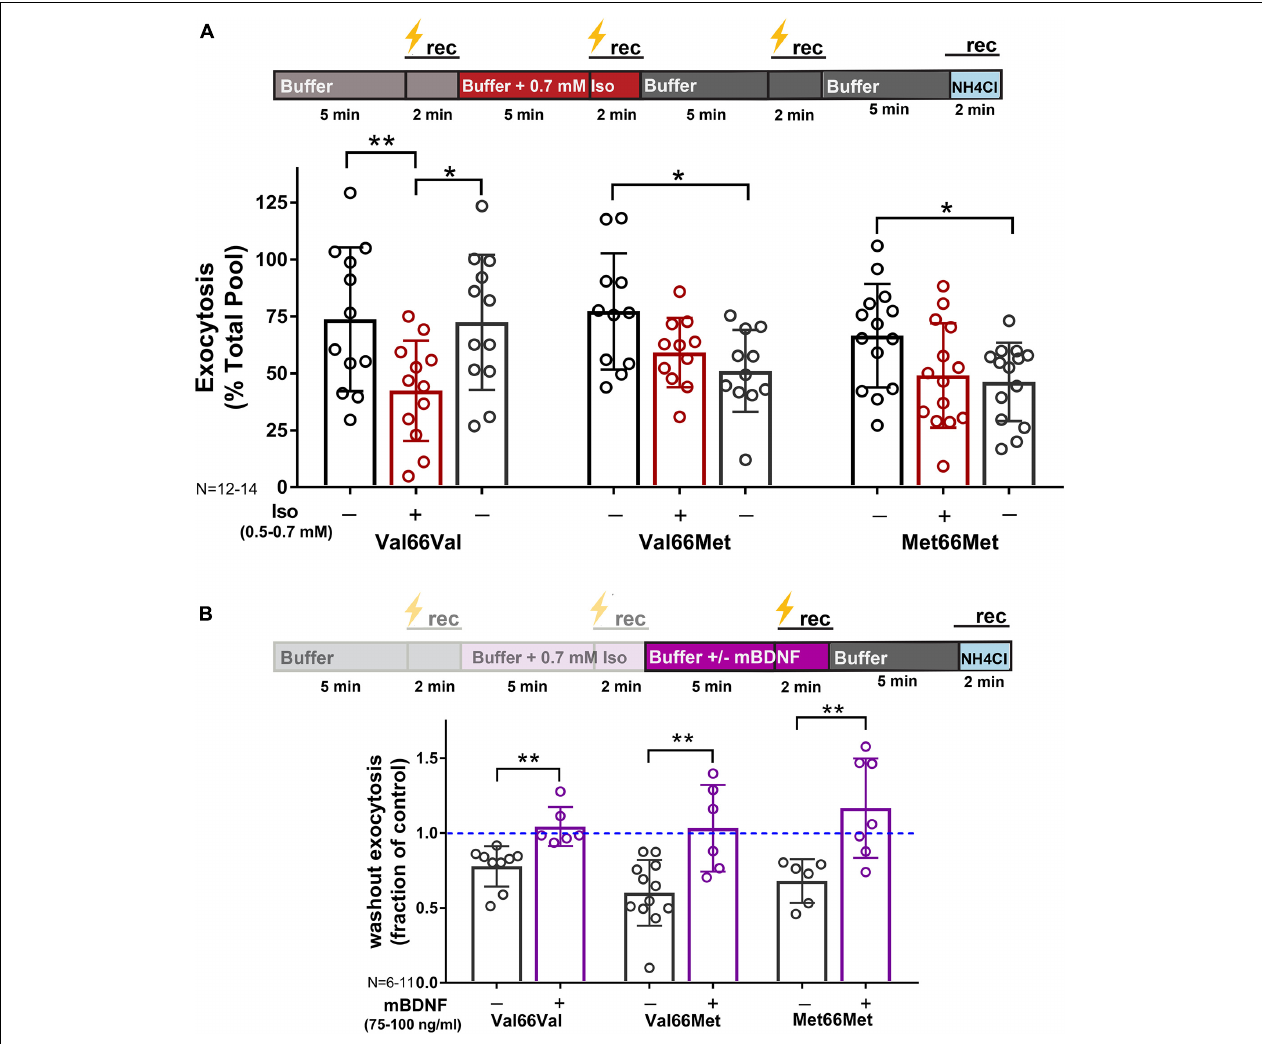
FIGURE 6 | Inhibition of synaptic vesicle exocytosis by isoflurane is acutely irreversible in Val66Met and Met66Met neurons, but rescued with exogenous BDNF. Mouse hippocampal neuron cultures (16DIV) transfected with vGlut-pH and mCherry were perfused with control buffer, 0.5–0.7 mM isoflurane, or mBDNF (75–100 ng/ml) with tetanic stimulation (lightning bolt) as indicated in ( A,B , top). Tetanic stimulation of synaptic vesicle exocytosis measured with vGlut-pH was inhibited by isoflurane (0.5–0.7 mM) in Val66Val mouse neurons compared to Val66Met and Met66Met neurons (** p < 0.01 by multiple comparisons one-way ANOVA with Dunnett’s post-hoc test). Changes in vesicle exocytosis observed in Val66Met and Met66Met neurons after isoflurane exposure did not recover following washout of drug ( A , bottom) (* p < 0.05 by multiple comparisons one-way ANOVA with Dunnett’s post-hoc test). Addition of 75–100 ng/ml of exogenous mBDNF